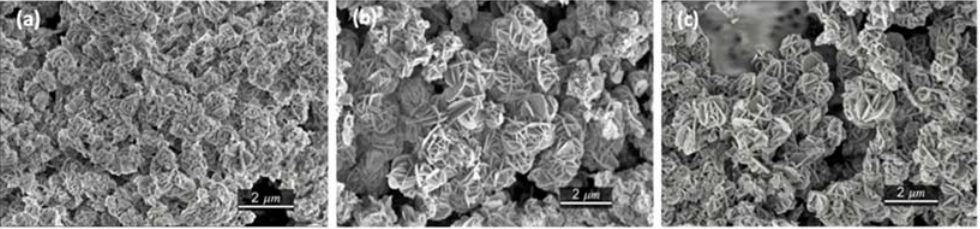
Figure 4. SEM images of the hydroxide precursors MW_15m ( a ), MW_30m ( b ), and MW_60m ( c ).